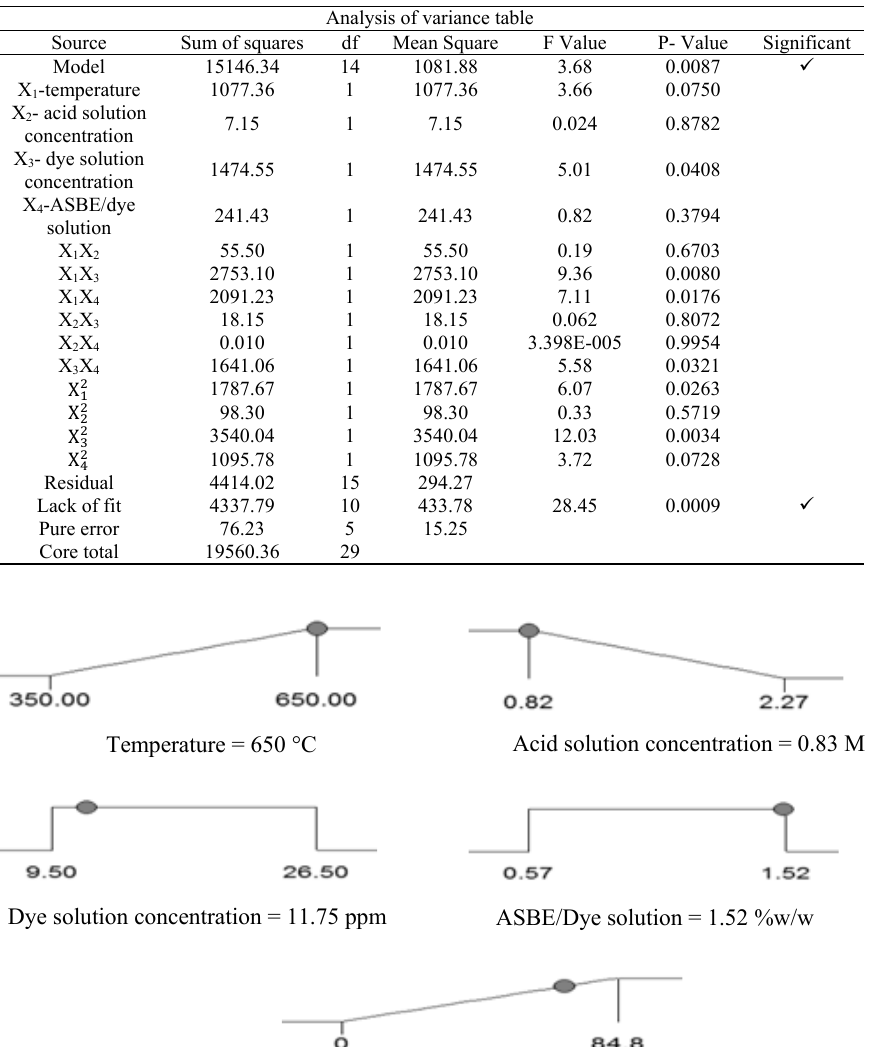
Table 2: ANOVA for dye adsorption